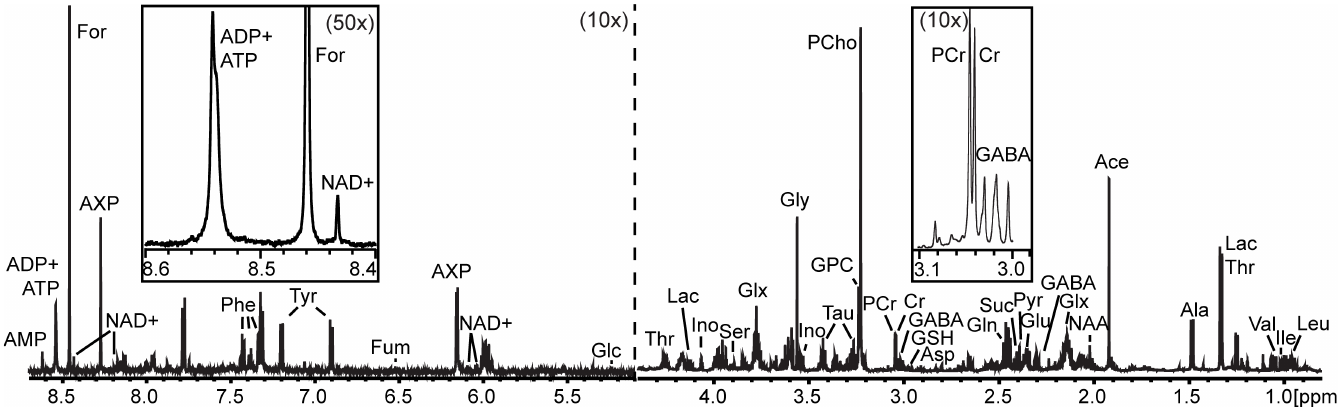
Fig 6. Representative NECo 1 H NMR spectra. 1 H NMR spectra at 600MHzfrom control NECo cultures from 0.8–4.5 ppm and from 5.0–8.8 ppm. 5.0– 8.8 ppm section is magnified10x relativeto 0.8–4.5 ppm section. Leu–leucine; Ile–isoleucine; Val–valine;Lac–lactate; Thr–threonine; Ala–alanine; Ace– acetate; NAA–N-acetyl aspartate; Glx–glutamine/glutamate; GABA- gamma-amino butyrate; Glu–glutamate; Pyr–pyruvate; Suc–succinate; Gln–glutamine; Asp–aspartate; Cr–creatine; PCr–phosphocreatine;PCho–phosphocholine; GPC–glycerophosphocholine;Tau–taurine; Gly–glycine; Ser–serine; Ino– myoinositol; Glc–glucose; Fum–fumarate; Phe–phenylalanine; Tyr–tyrosine; AXP–combined adeninenucleotides; For–formate. Acetate and formate peaks are contaminants from sample preparation. Insets–Metabolitesquantifiedfor this study. Right, PCr and Cr peaks, 10x magnified.Left, ADP+ATP peak, 50x